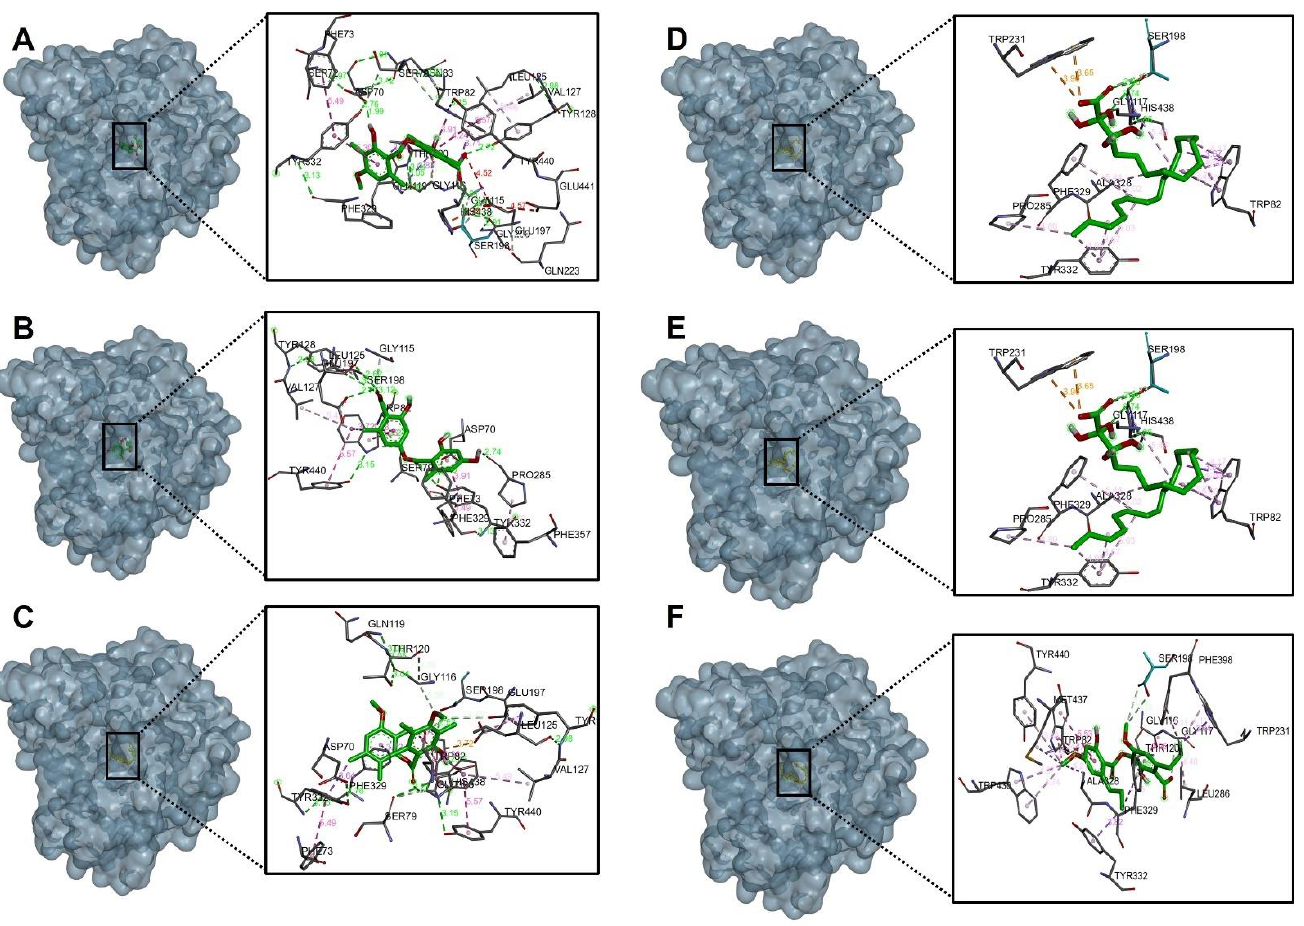
Figure 5. Binding mode and predicted intermolecular interactions of selected compounds from Lecania brialmontii , Pseudephebe pubescens and Sphaerophorus globosus extracts and residues of the human butyrylcholinesterase (hBChE) catalytic site; ( A ) Barbatic acid at the catalytic site; ( B ) Lecanoric acid at the catalytic site; ( C ) Brialmontin 2 at the catalytic site; ( D ) Tetrahydroxy-tricosanoic acid at the catalytic site; ( E ) Sphaerophorin at the catalytic site; ( F ) Sekikaic acid at the catalytic site.